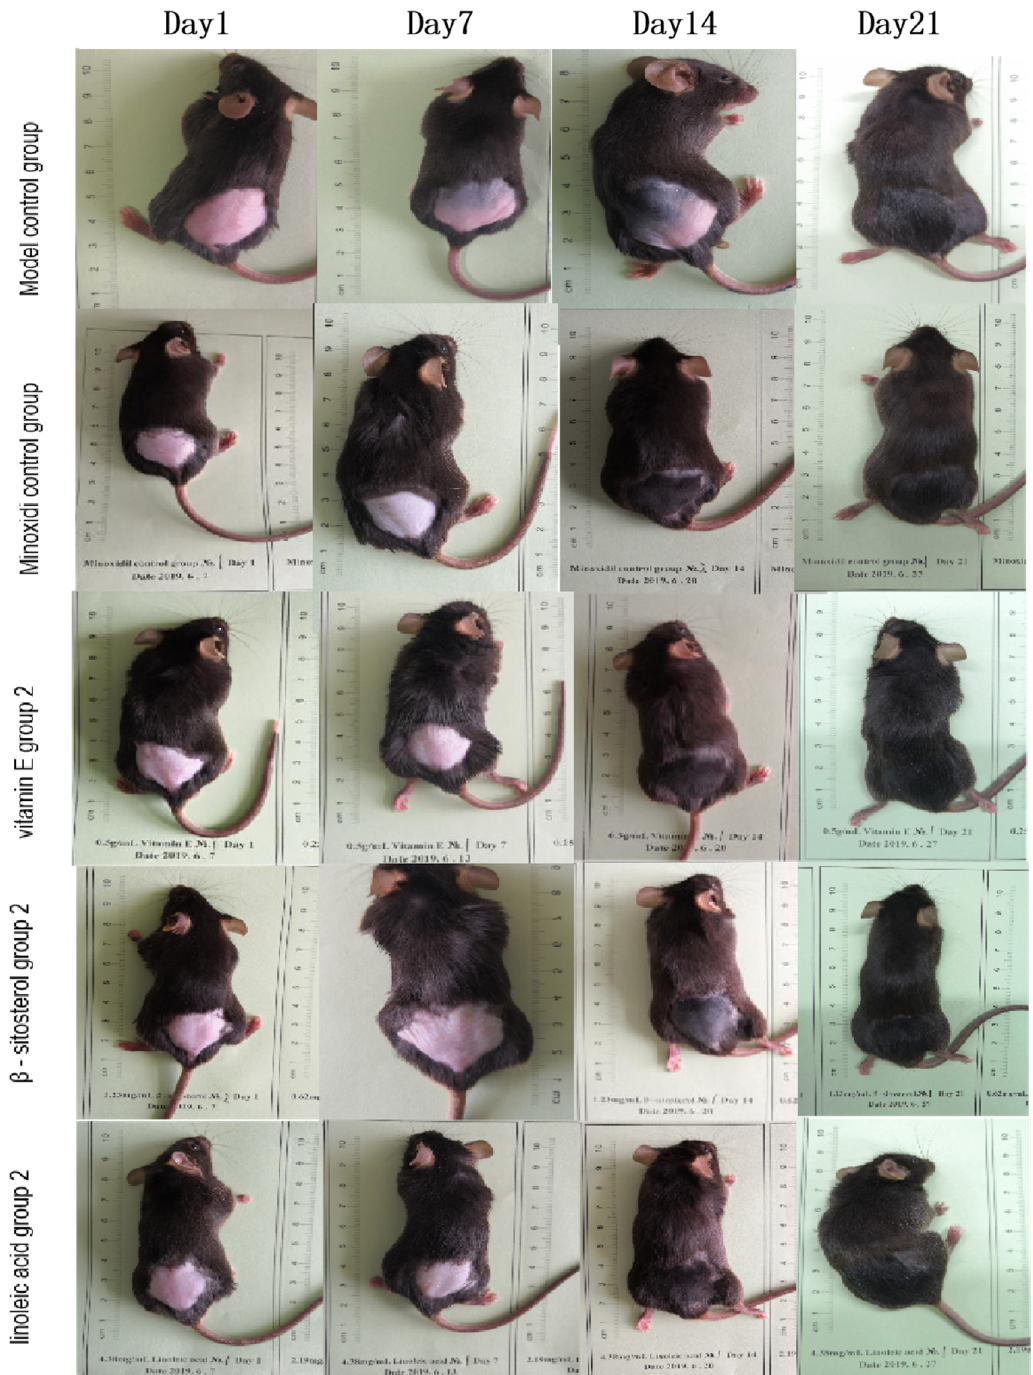
Figure 13. The effect of three effective components of the kernel of P. mira on the hair growth of C57BL/6 mice depilation model induced by sodium sulfide.